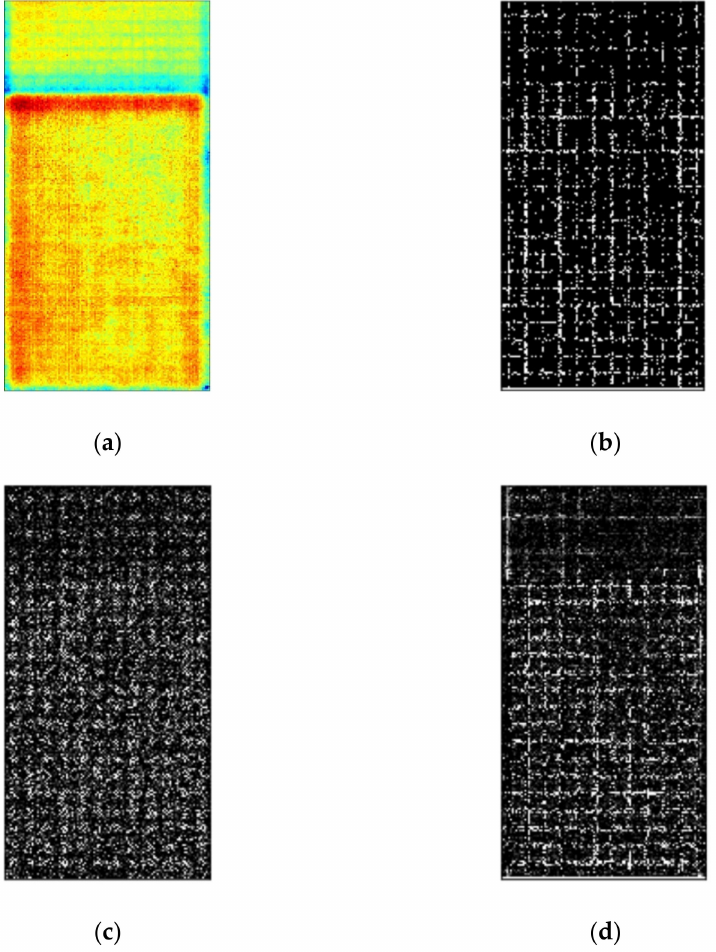
Figure 14. Edge detection results: ( a ) original image, ( b ) Canny result, ( c ) Sobel result, ( d ) Laplacian